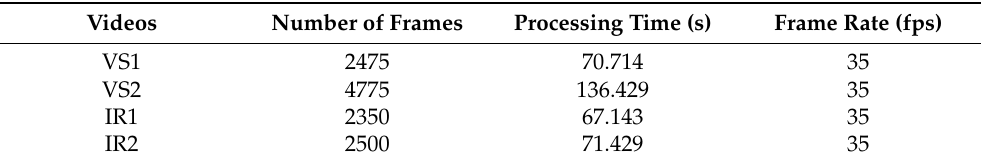
Table 7. The processing time analysis with the novel system running offline. (Note that the system works online at a frame rate of 25 fps).